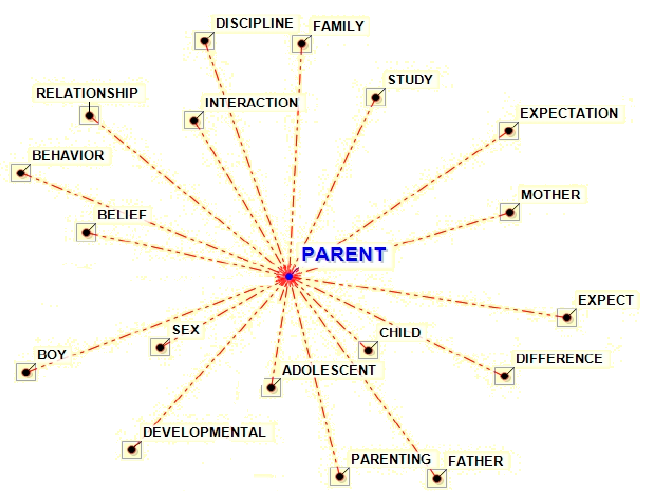
Figure 4. Radial diagram with Parent.